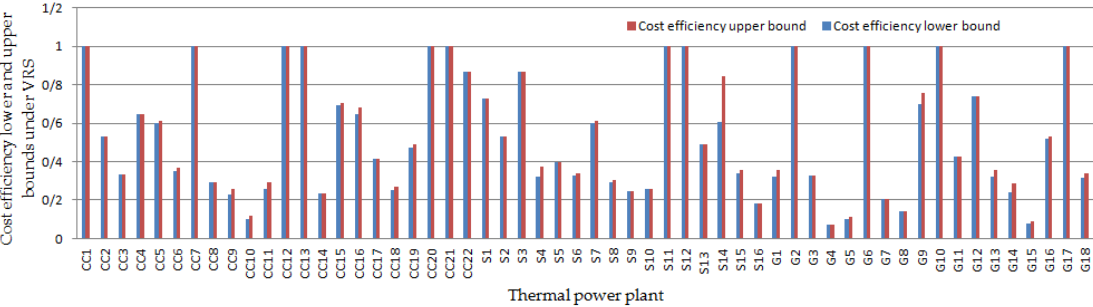
Figure 3. Comparisons of cost efficiency lower and upper bounds of 56 thermal power plants under VRS with the semi-disposability